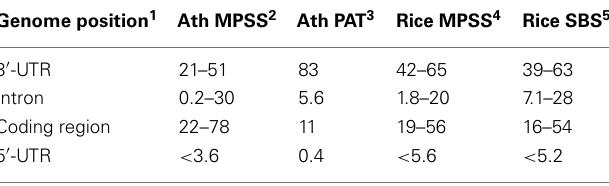
Table 1 | Genomic position of poly(A) sites in genome-wide